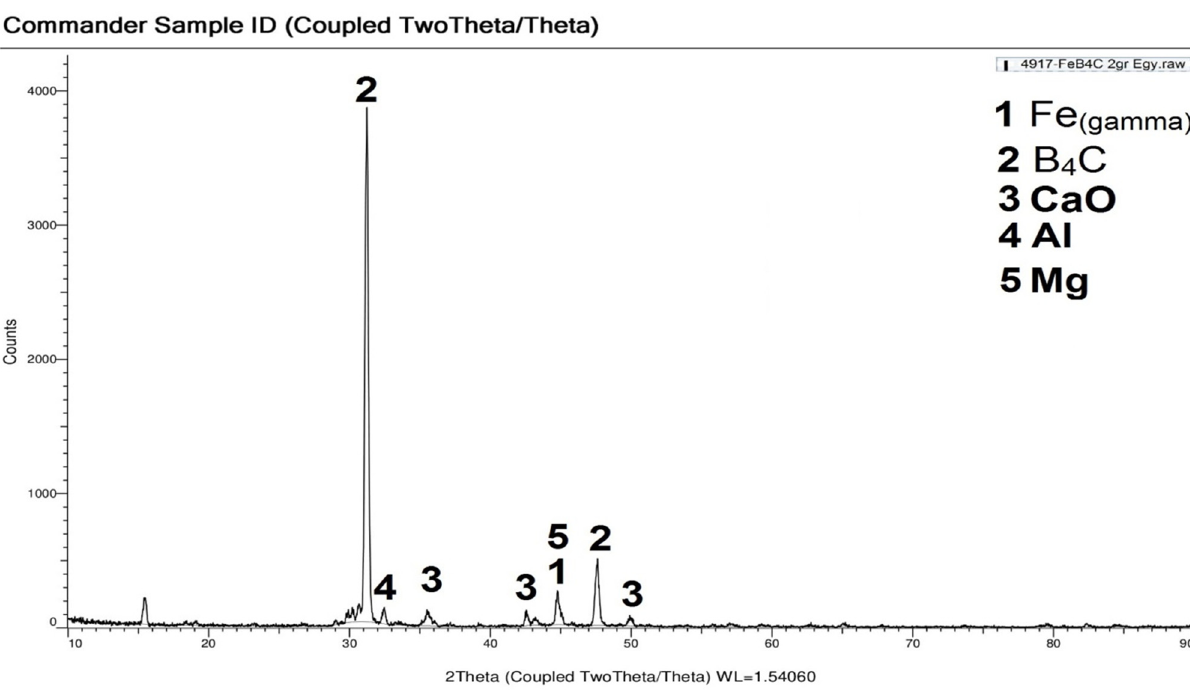
Figure 11: XRD analysis of 91.66% Fe – 1.66% B 4 C – 6.66% egg